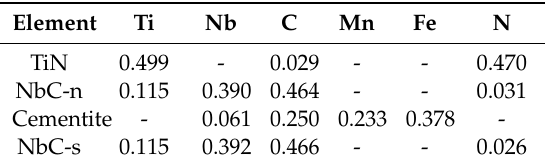
Table 2. The predicted precipitates compositions (in mass fraction) using MatCalc ® and considering the processing parameters: FRT = 780 ◦ C, a = 20 K · s − 1 and CT = 350 ◦ C. Element Ti Nb C